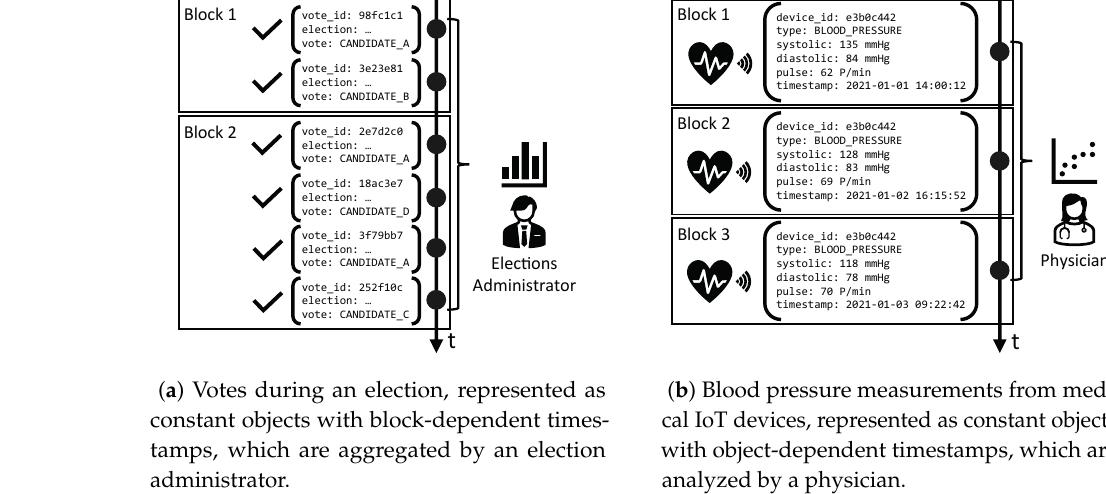
Figure 2. Two different use cases utilizing constant objects with ( a ) block-dependent timestamps and ( b ) object-dependent